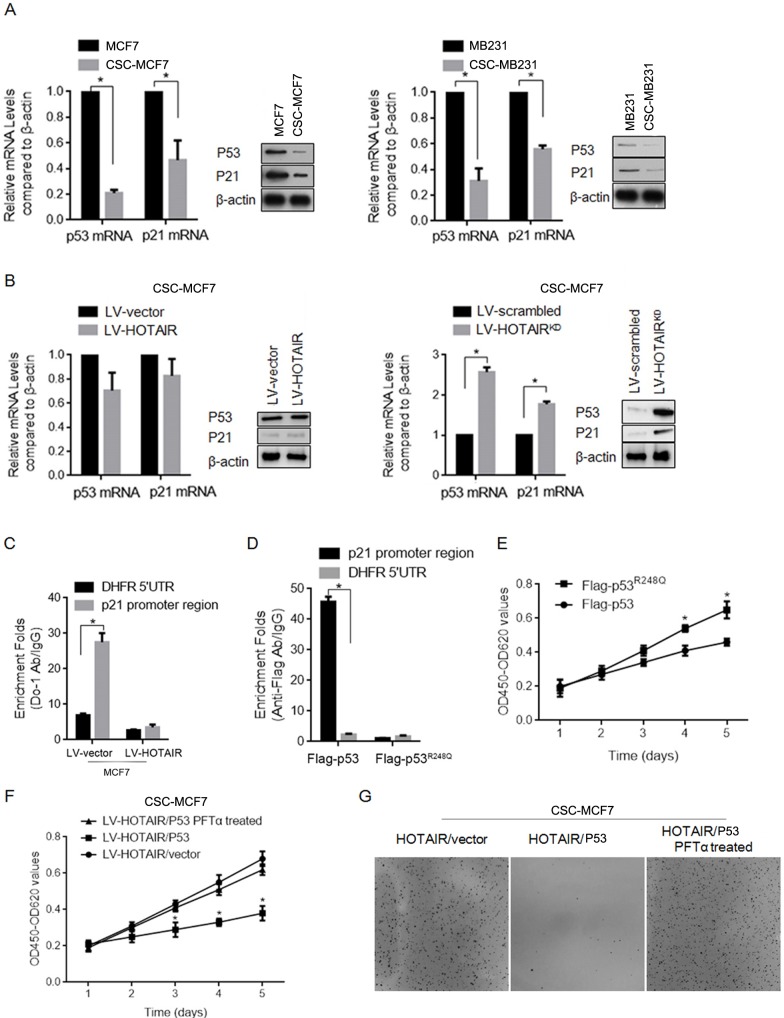
HOTAIR modifies the p53/p21 pathway and thus regulates CSC proliferation and colony formation.(A) RT-qPCR and semi-quantitative western blotting were applied to detect the mRNA and protein levels of p53 and p21 in original or CSC-MCF7 and CSC-MB231 cells. (B) After introduction of HOTAIR or shRNA targeting HOTAIR into CSCs, expression of p53 and p21 was detected. (C and D) A ChIP assay was performed to detect the binding of native p53 in MCF7 cells (C) or ectopic expressed Flag-P53 in CSCs (D) to the p21 promoter region. (E) A CCK-8 assay to detect CSC-MCF7 cells transfected with Flag-p53R248Q or Flag-p53. (F and G) CCK-8 (F) and colony formation (G) assays to detect the proliferation rate of CSC-MCF7-LV-HOTAIR with p53 reintroduction and co-culture with 30 μM PFTα. *P<0.05.